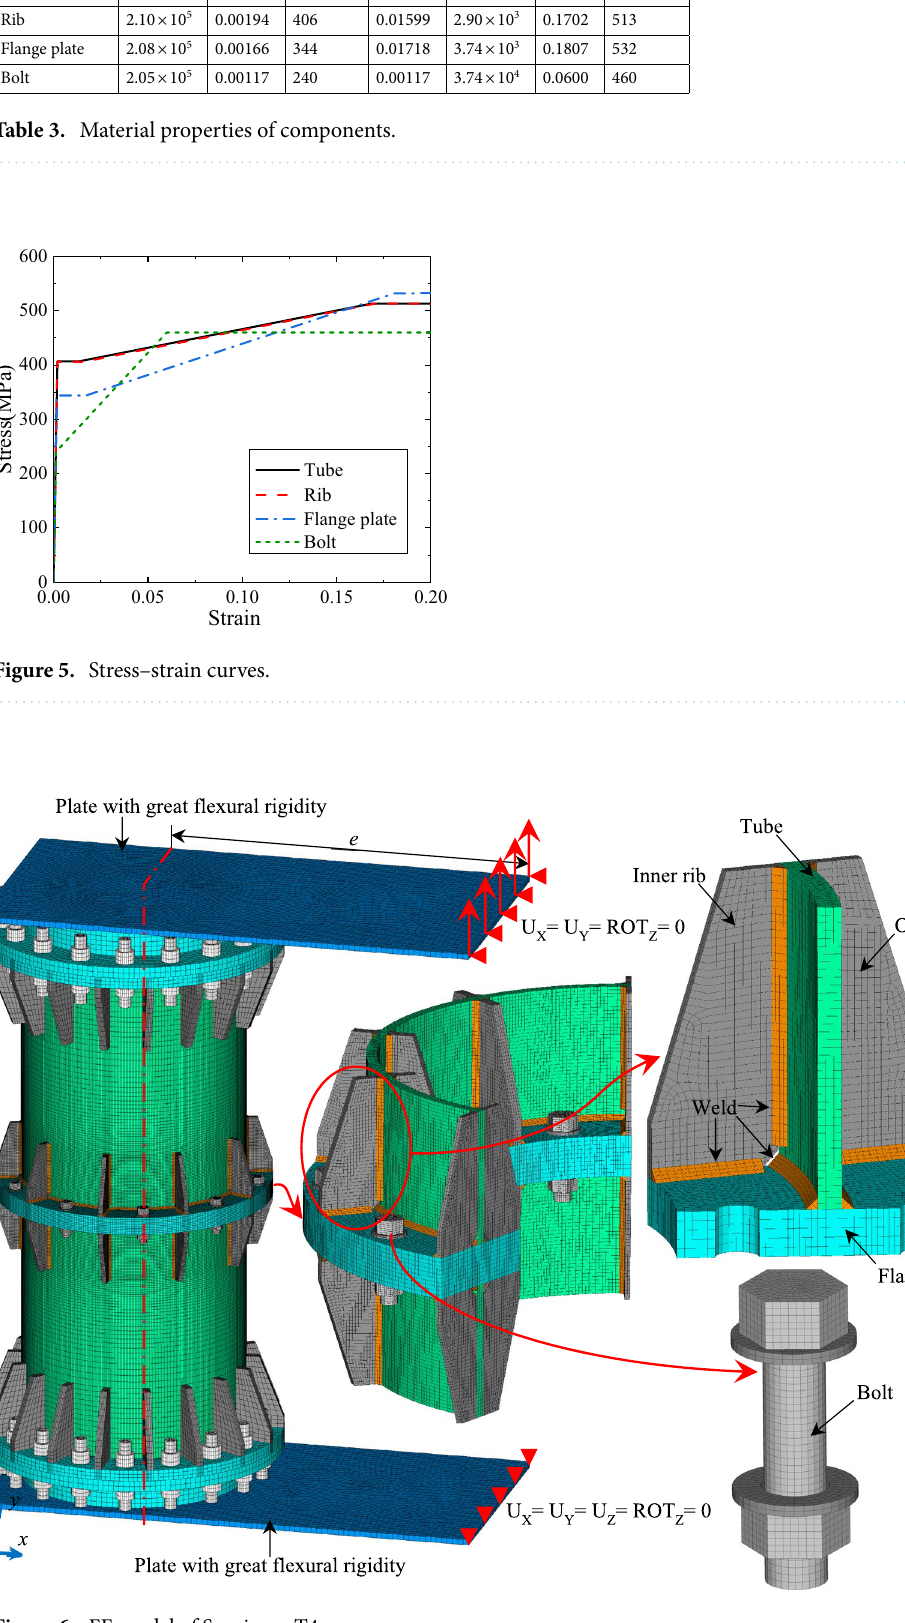
Figure 6. FE model of Specimen